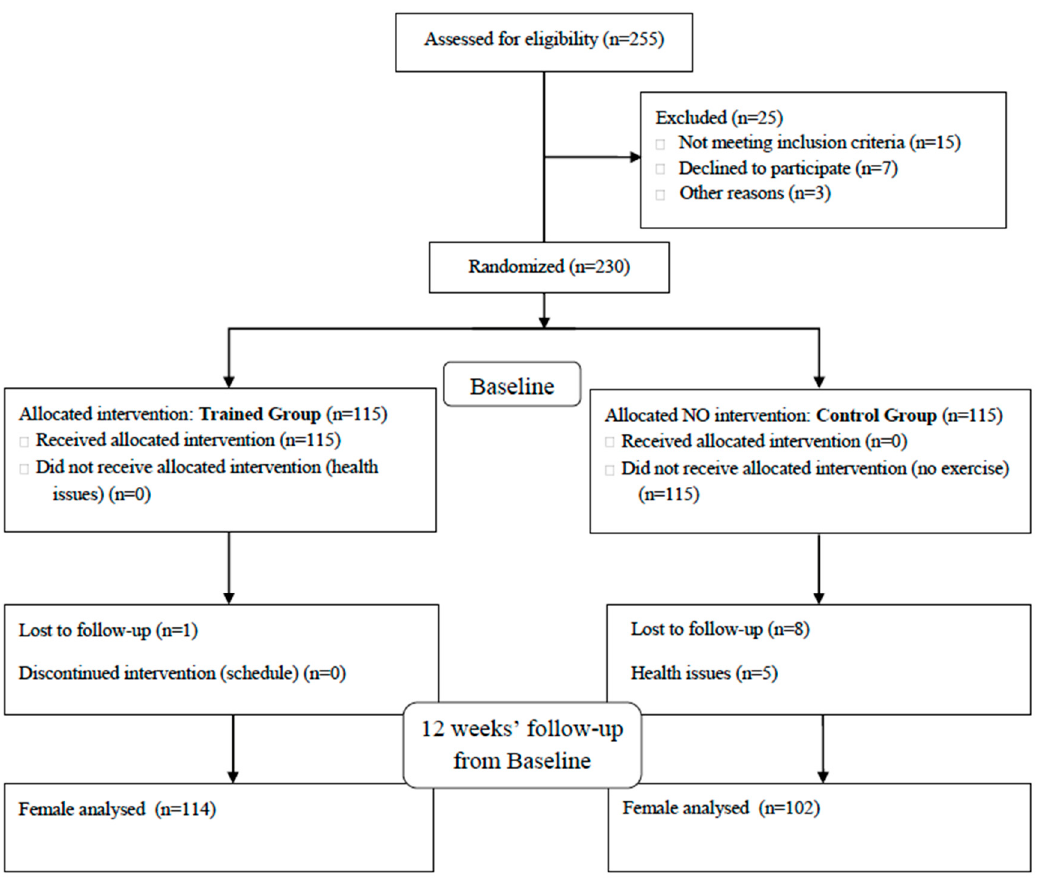
Figure 1. Flow diagram of the sample.